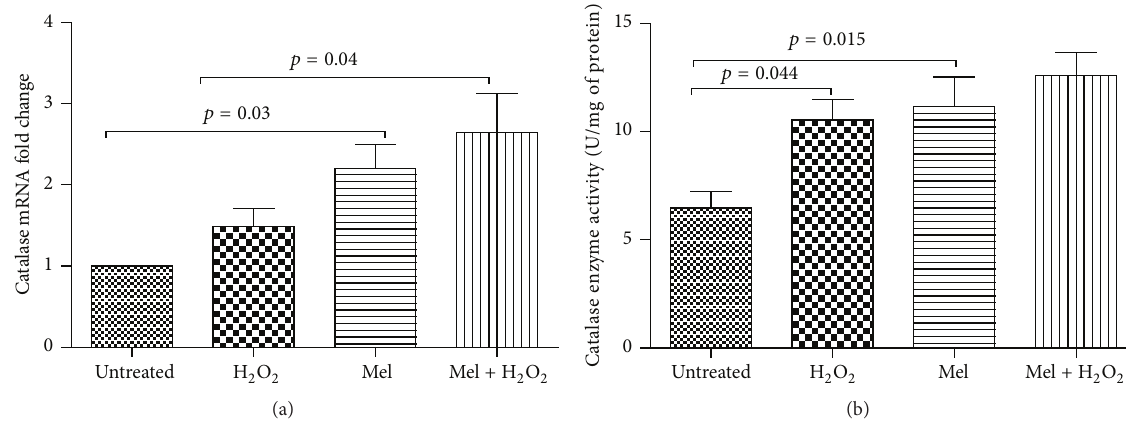
Figure 4: Effect of melatonin, H healthy subjects. PBMCs were treated as follows: untreated (only with 0.1% DMSO for 12h); melatonin (1mM) for 12h; H 2 h; and melatonin plus H were treated with 0.1% of DMSO as a control. Data are expressed as mean ±